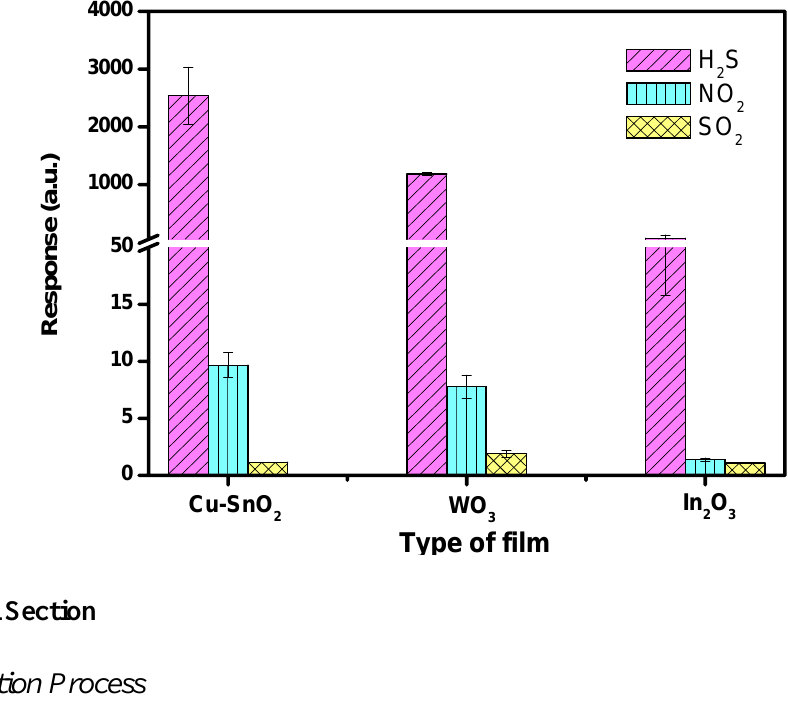
Figure 6. Responses of Cu-SnO SO at their optimum operating temperature. 2